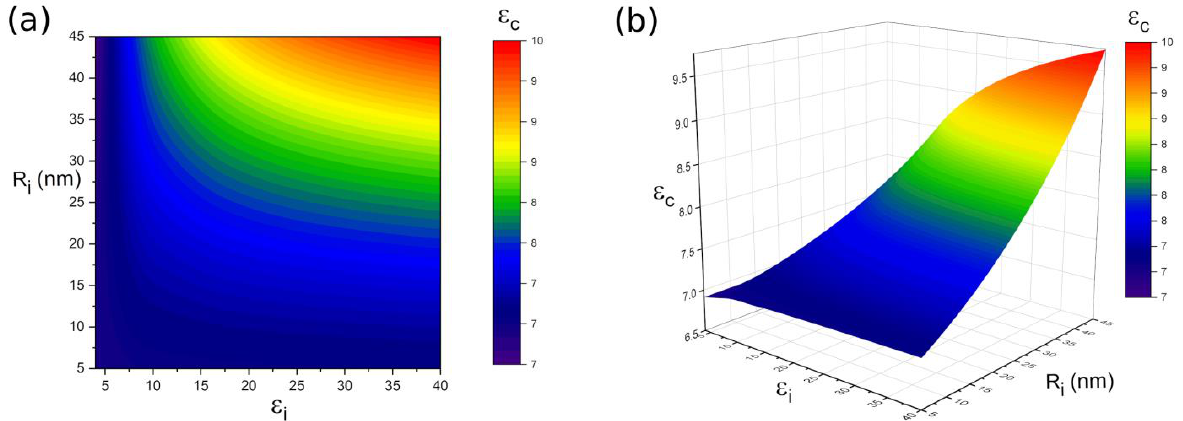
Figure 5. The dependence of ε c to the ε i and R i when ε f = 50, ε m = 6, R = 100 nm and V f = 0.1 ( a ) contour plot; ( b ) 3D plot.